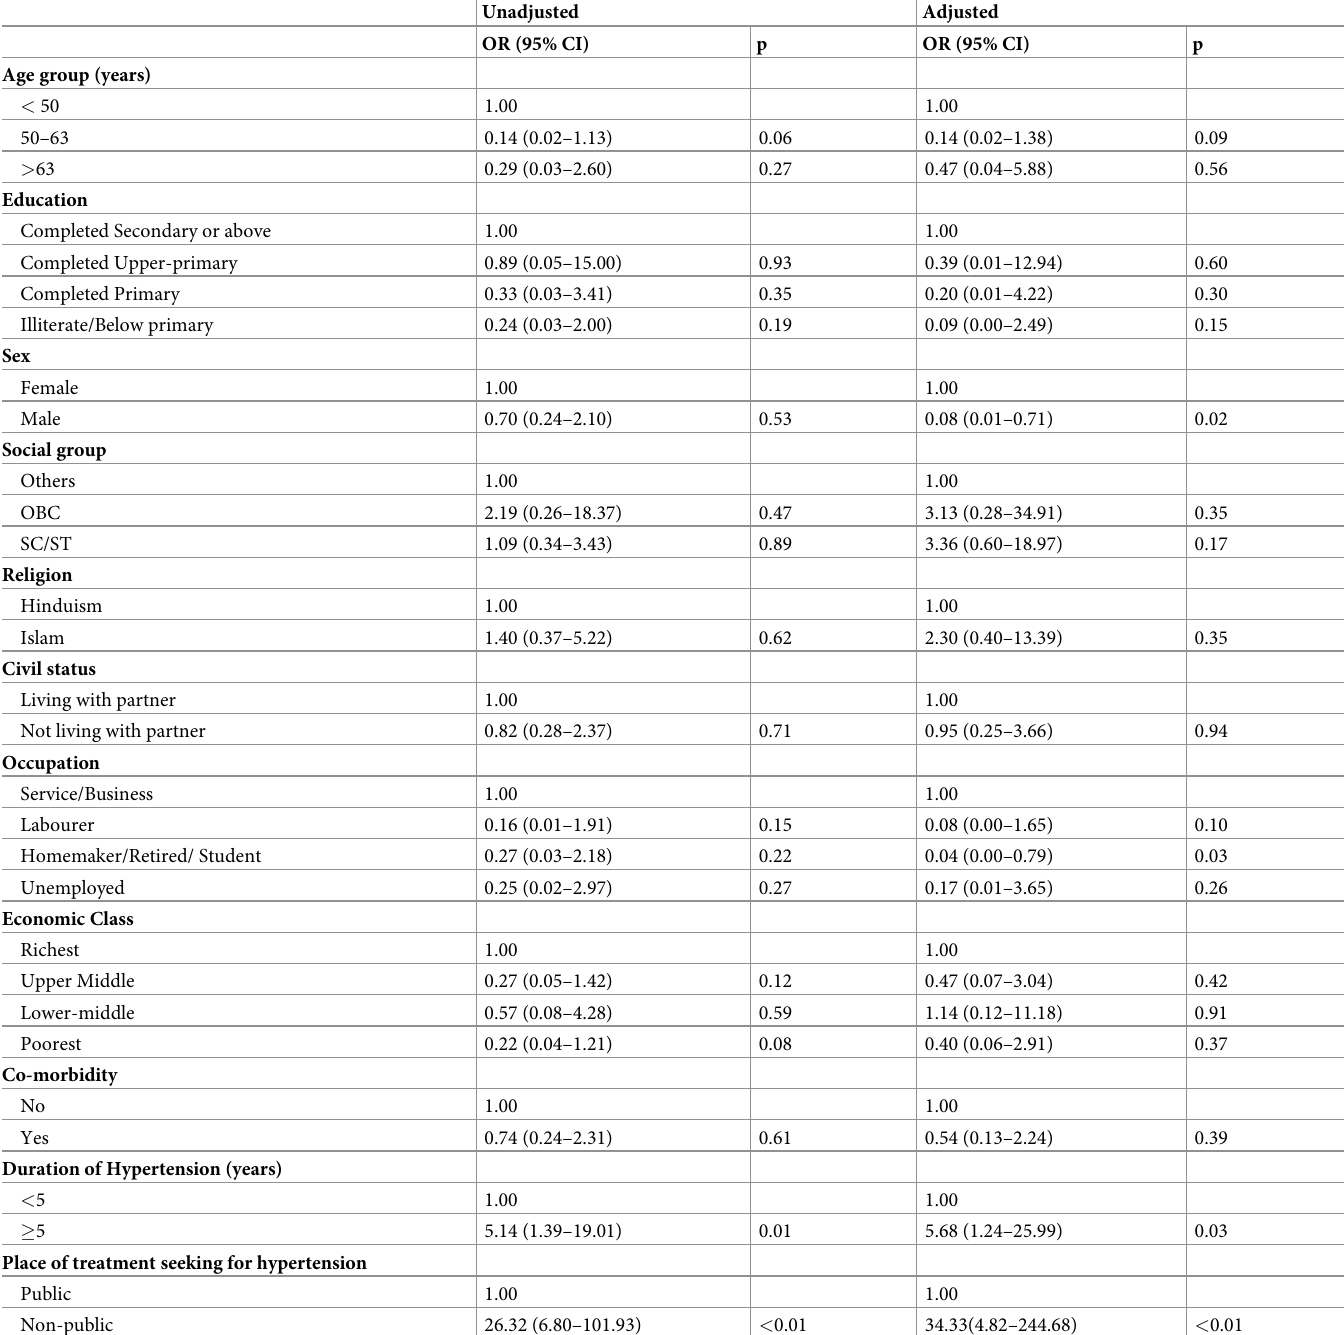
Table 2. Factors associated with out of pocket payments: Logistic regression analysis (N = 159).